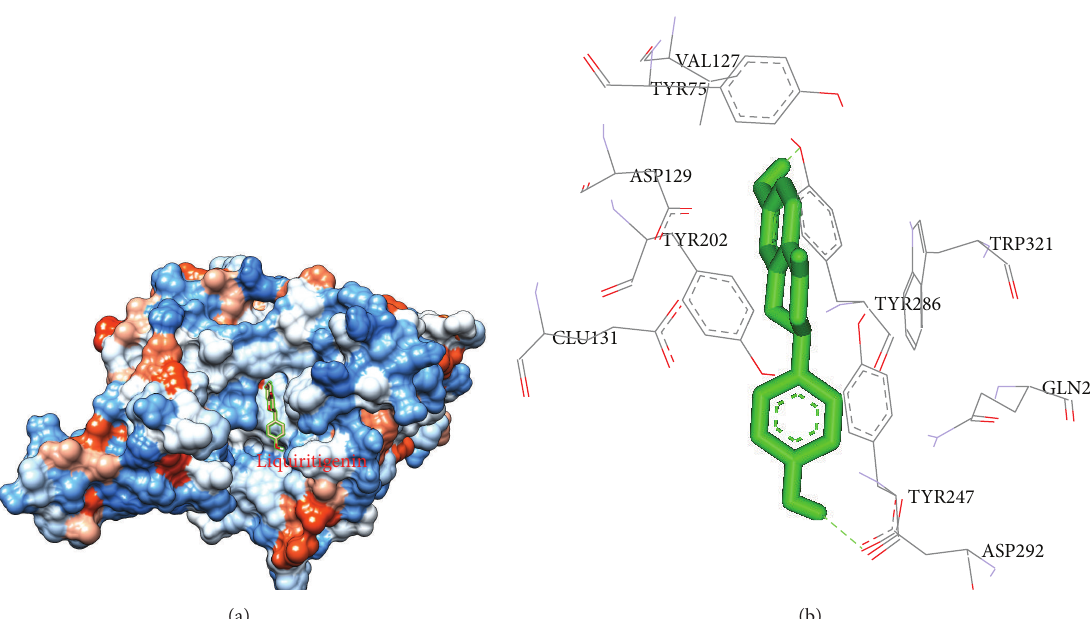
Figure 9: Docked pose corresponding to the minimum energy conformation for liquiritigenin binding to HAase. (a) The hydrophobicity of HAase with liquiritigenin. (b) Detailed illustration of the amino acid residues lining the binding site in the HAase cavity. Green molecule displays liquiritigenin; broken lines display hydrogen